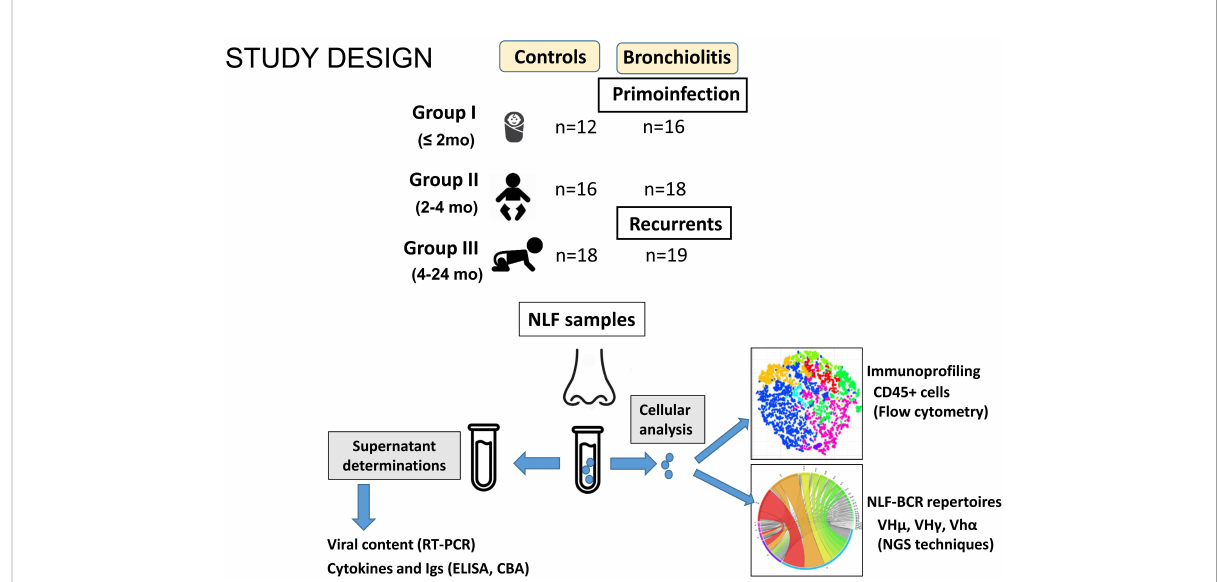
FIGURE 1 Scheme summarizing the study design. NLF samples were obtained from the indicated groups. Supernatants were used for RT-PCR, CBA and ELISA analysis to determine the viral content, cytokine pro fi le and antibody composition, respectively. The cells recovered from NLF from bronchiolitis patients were used for immunopro fi ling by using fl ow cytometry and for BCR IgH repertoire analyses after RNA extraction, cDNA preparation, ampli fi cation, barcoding and NGS